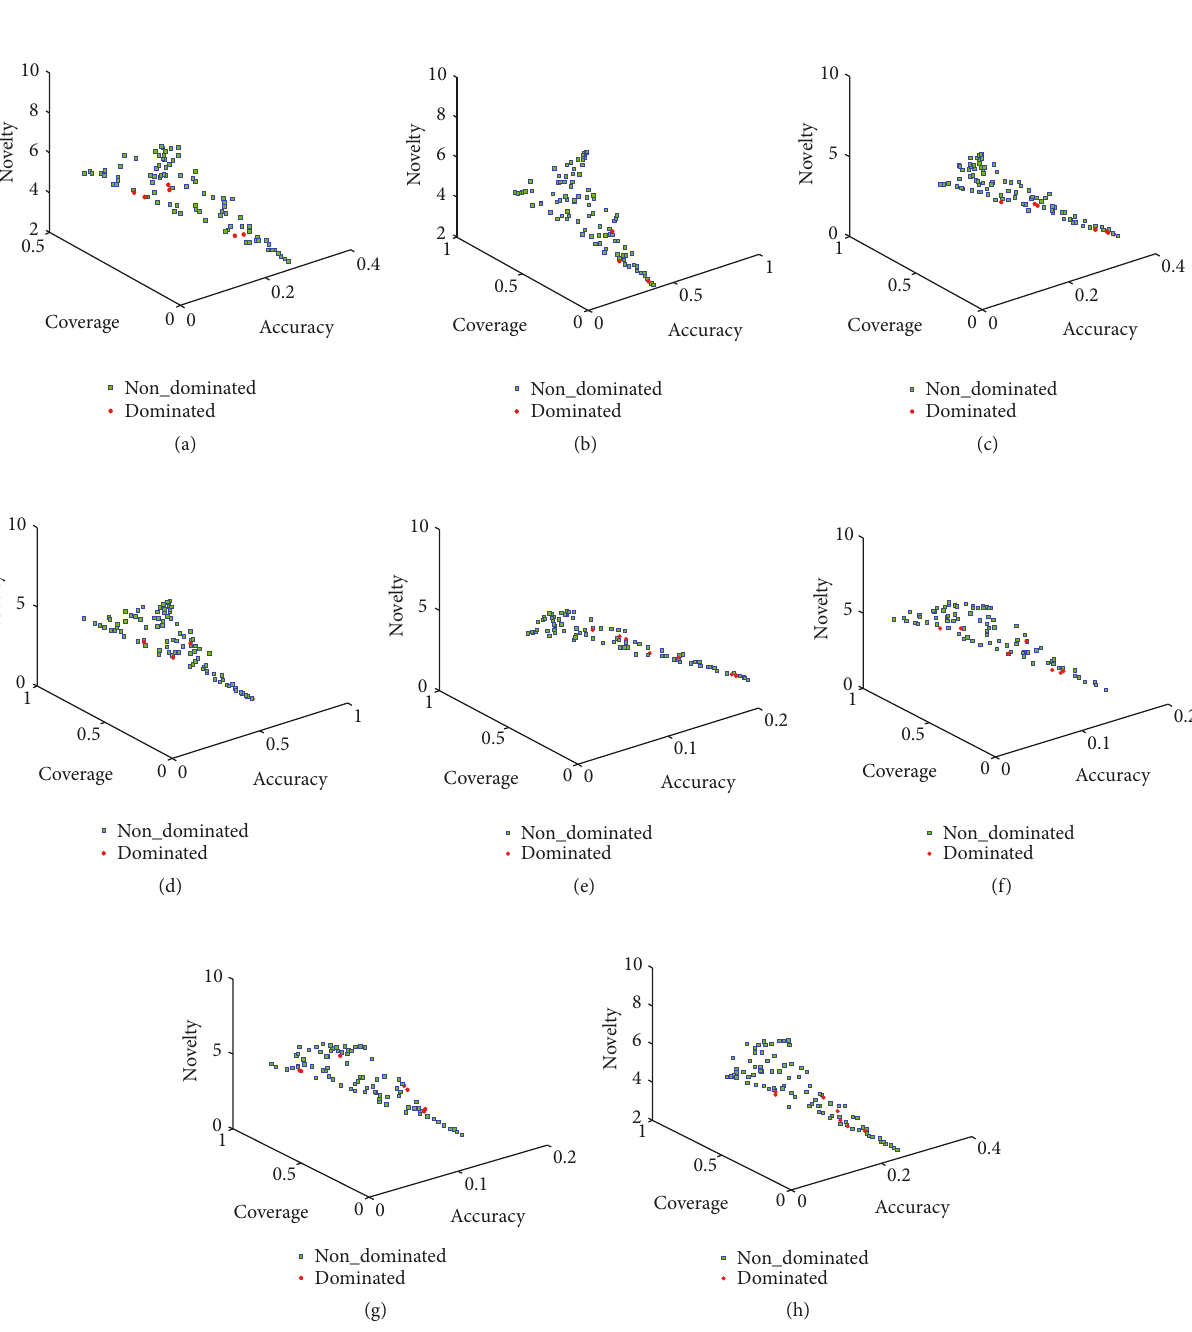
Figure 6: Final solutions of MOEA-EPG under the accuracy-coverage-novelty space for (a) Movielens 1, (b) Movielens 2, (c) Movielens 3, (d) Movielens 4, (e) Netflix 1, (f) Netflix 2, (g) Netflix 3, and (h) Netflix